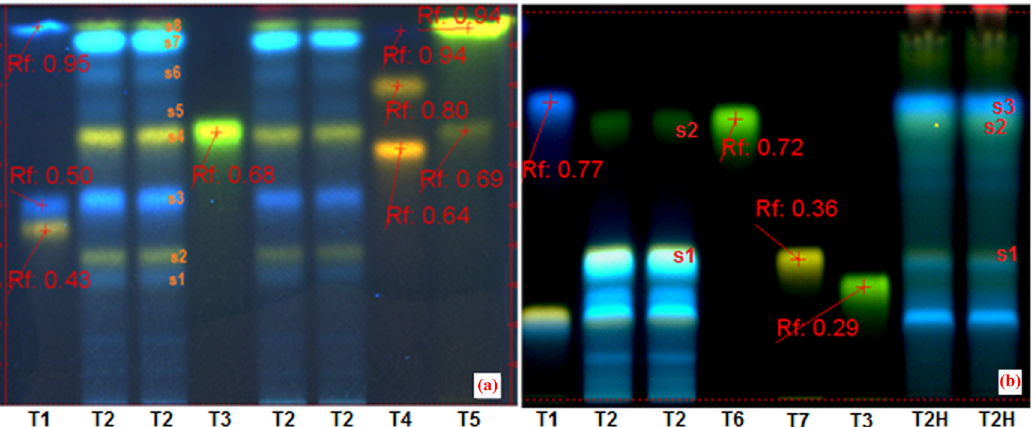
Figure 2: ( HP ) TLC studies of Stokesia laevis ethanolic extract ( Slae26 ) . Chromatogram A ( system a ) – track T1, rutin, chlorogenic acid and ca ff eic acid ( ref. ) ; tracks T2 – ethanolic extract from S. laevis ( Slae26 ) – two series; track T3, luteolin - 8 - C - glucoside/orientin ( ref. ) ; track T4, quercitrin - 3 - O - galactoside/hyperoside, quercitrin - 3 - O - rhamnoside/quercitrin and gallic acid ( ref. ) ; track T5, luteolin - 7 - O - glucoside/ cynaroside and luteolin ( ref. ) . Chromatogram B ( system b ) – track T1, rutin, chlorogenic acid and ca ff eic acid ( ref. ) ; tracks T2 – ethanolic extract from S. laevis ( Slae26 ) ; track T6, luteolin ( ref ) ; track T7, luteolin - 7 - O - glucoside/cynaroside ( ref. ) ; track T3, luteolin - 8 - C - glucoside/ orientin ( ref. ) ; track T2H, the hydrolyzed extract from ethanolic extract